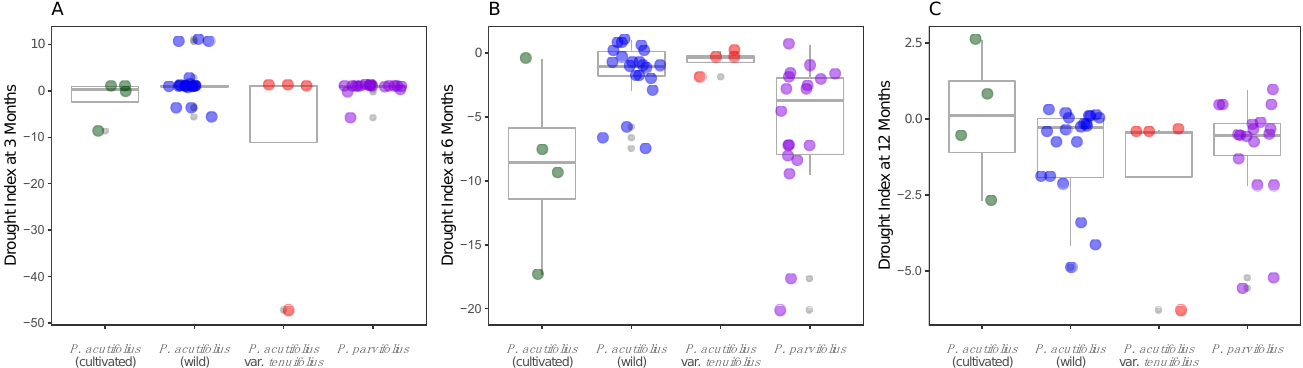
Figure 2. Dispersal graph boxplots for habitat drought stress index in four taxonomical divisions of broad sense ( s.l. ) tepary bean (from the P. acutifolius–parvifolius clade) based on the Thornthwaite’s potential evapotranspiration (PET) model. Drought indices computed at ( A ) three, ( B ) six, and ( C ) 12 months. Colors mark taxonomy: Green and blue for cultivated P. acutifolius and wild P. acutifolius , red for wild P. acutifolius var. tenuifolius , and purple for wild P. parvifolius .